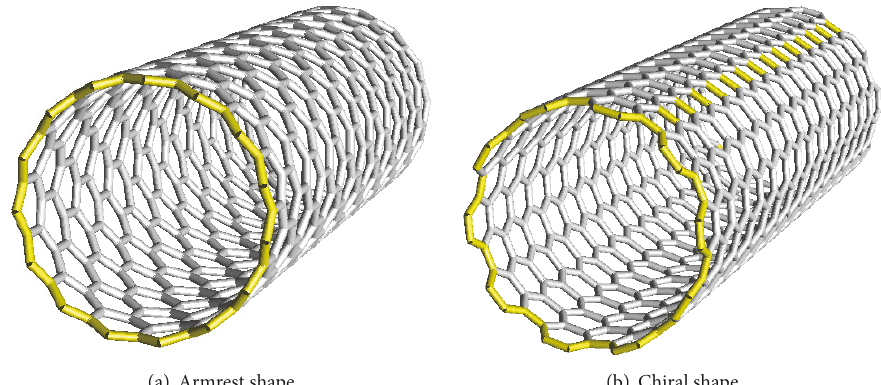
Figure 6: Modeling for carbon